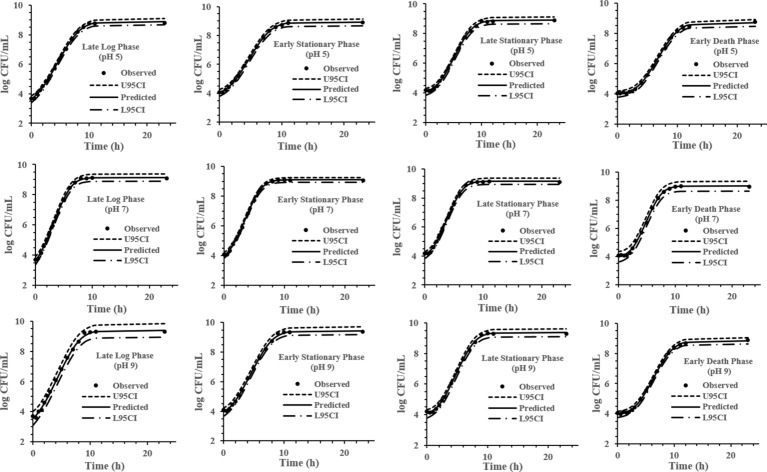
Baranyi model for S. Typhimurium DT104 brain heart infusion broth (BHI) at pH 5, 7, and 9 at 37°C. Observed, predicted, upper 95% confidence interval (U95CI), and lower 95% confidence interval (L95CI).